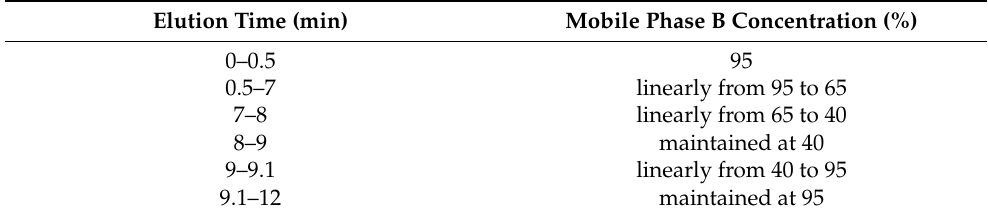
Table 4. The gradient elution